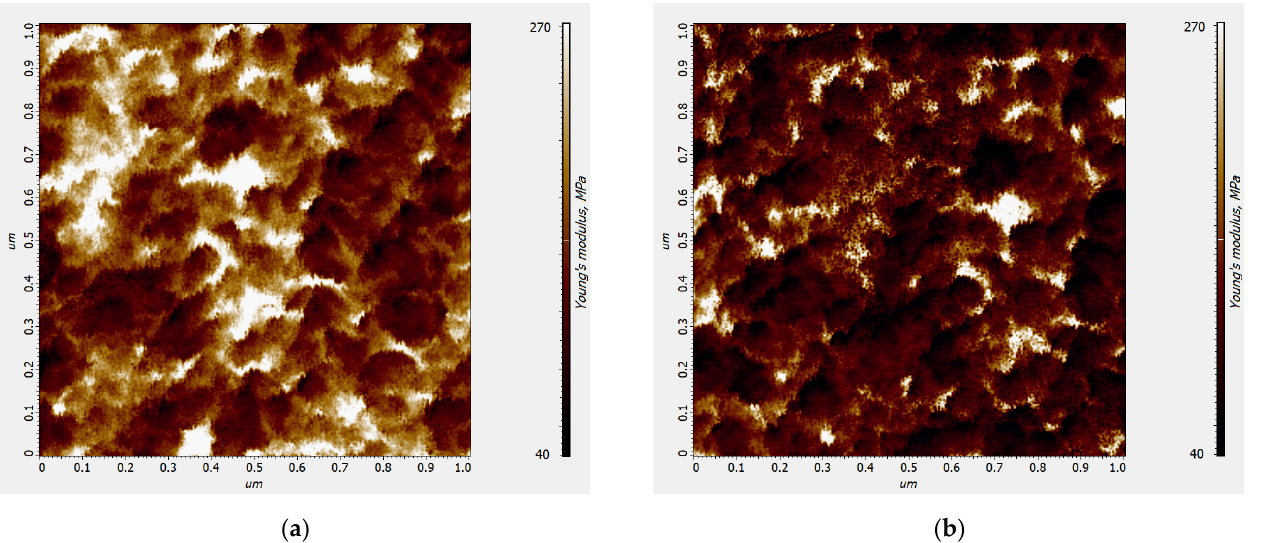
Figure 6. The maps of Young’s modulus of the poly[NiSalphen(CH 3 O) 2 ] film in 0.1 M Et 4 NBF 4 /PC in the uncharged ( a ) and charged ( b ) states acquired by EC-HD QNM AFM.